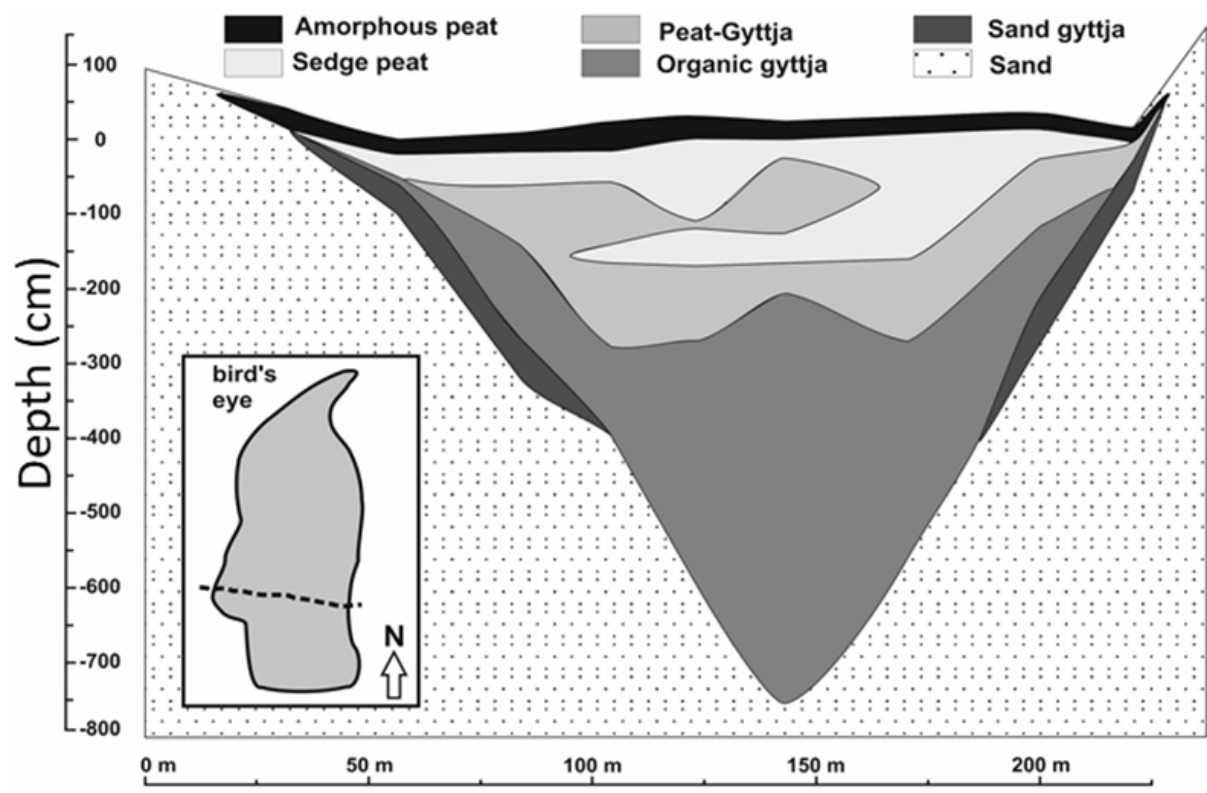
Figure 3. Detailed stratigraphy of the deposits in Vasi-North, which was described from five cores spaced approximately 50 m apart. The small map (left) shows the position of the transect in the